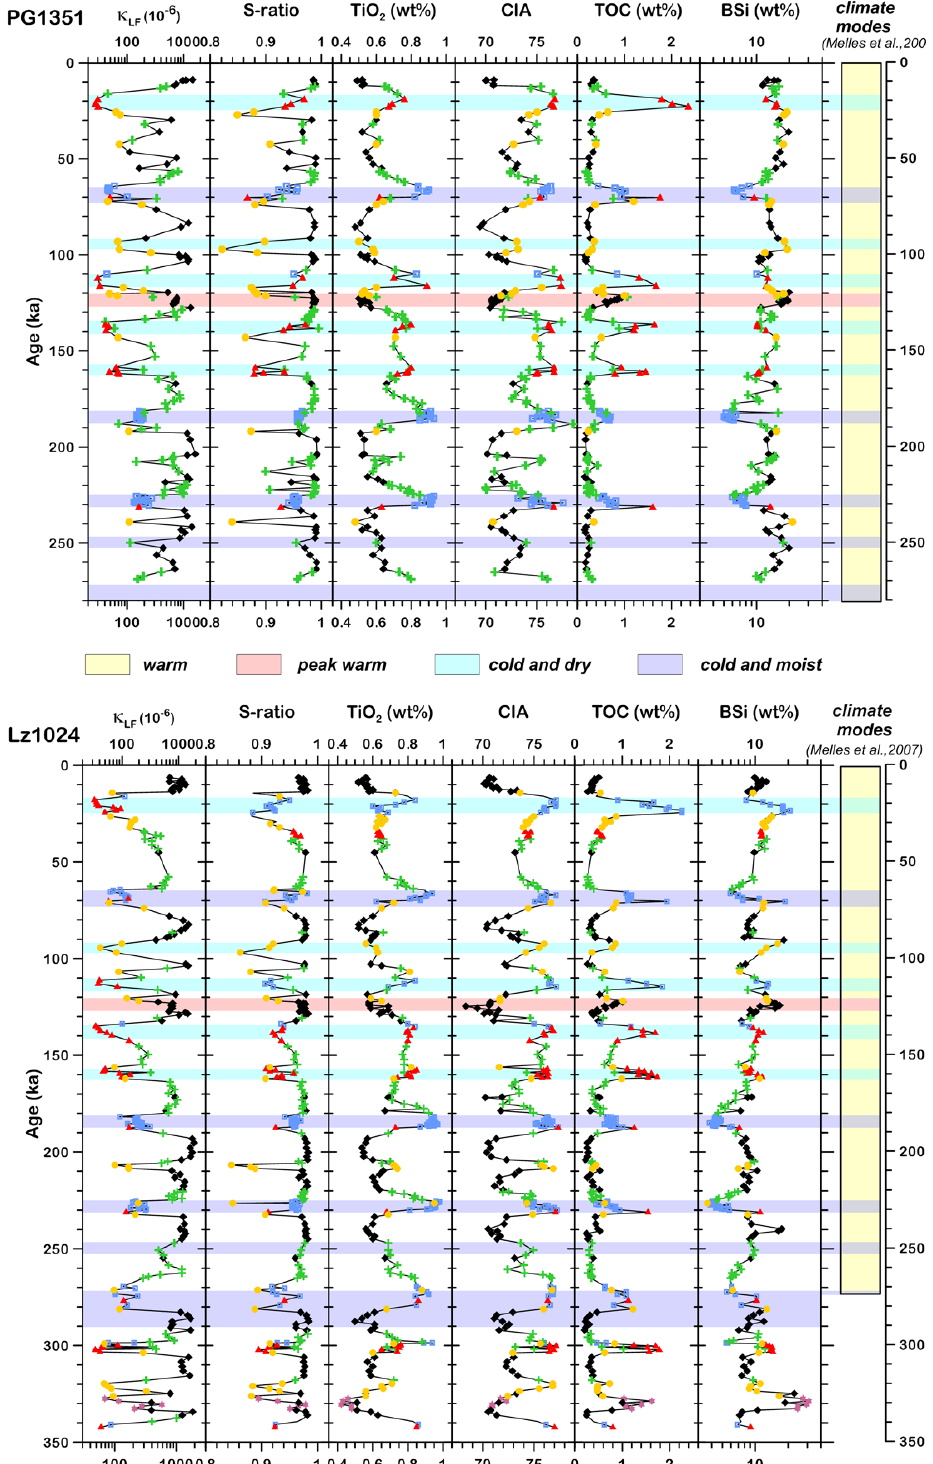
Fig. 4. Comparison of the results of the cluster analysis for core PG1351 and core Lz1024, with the pattern of climate modes defined for Lake El’gygytgyn (Melles et al., 2007) versus age. The ages of the climate zone boundaries were adjusted with regard to the new chronologies by Nowaczyk et al. (2012, 2013). The different symbols and colours denoting the five (six) clusters are superimposed on plots of the parameter records used for cluster calculation. For further details see